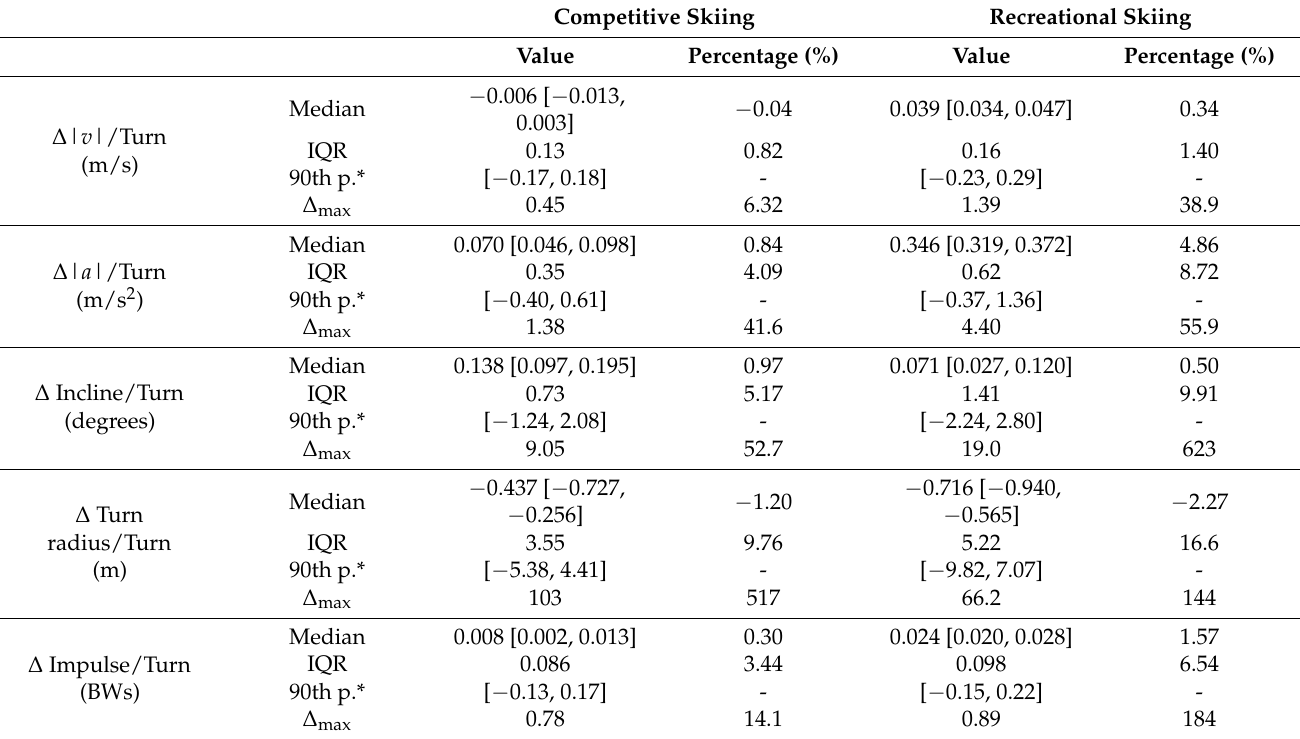
Table 5. Errors for turn average values for speed ( ∆ | v |), acceleration ( ∆ | a |), trajectory incline ( ∆ Incline), turn radius ( ∆ Turn radius) and impulse ( ∆ Impulse/Turn) for competitive and recreational skiing. Data are presented as median (with confidence intervals), interquartile range (IQR) and maxi- mal error ( ∆ max) in parameter units and %. Number of turns: competitive skiing: 599, recreational skiing: 2145. Nomenclature: bodyweight seconds (BWs), p.* = 90th percentile.